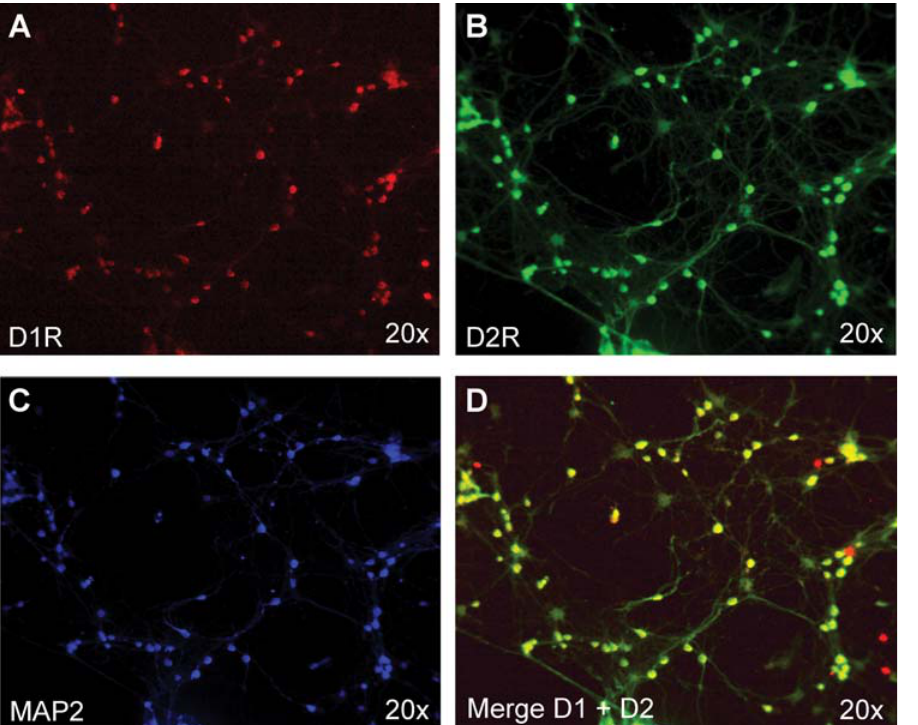
Figure 1. The dopamine receptor subtypes, D1R and D2R, are both expressed in cultured hippocampal neurons (A–D). D1 receptors are shown in red (A); D2 receptors are shown in green (B); MAP2 expression (soma and dendrites) is shown in blue (C); the merged image (D) indicates colocalization (yellow).